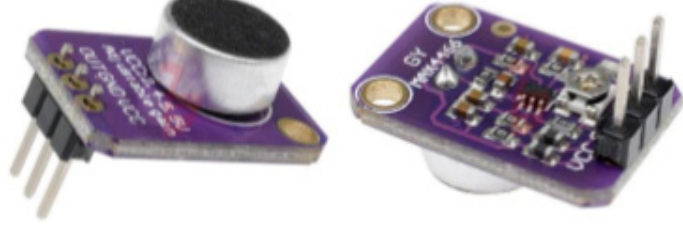
Figure 5. Microphone amplifier GY-MAX4466 [58].